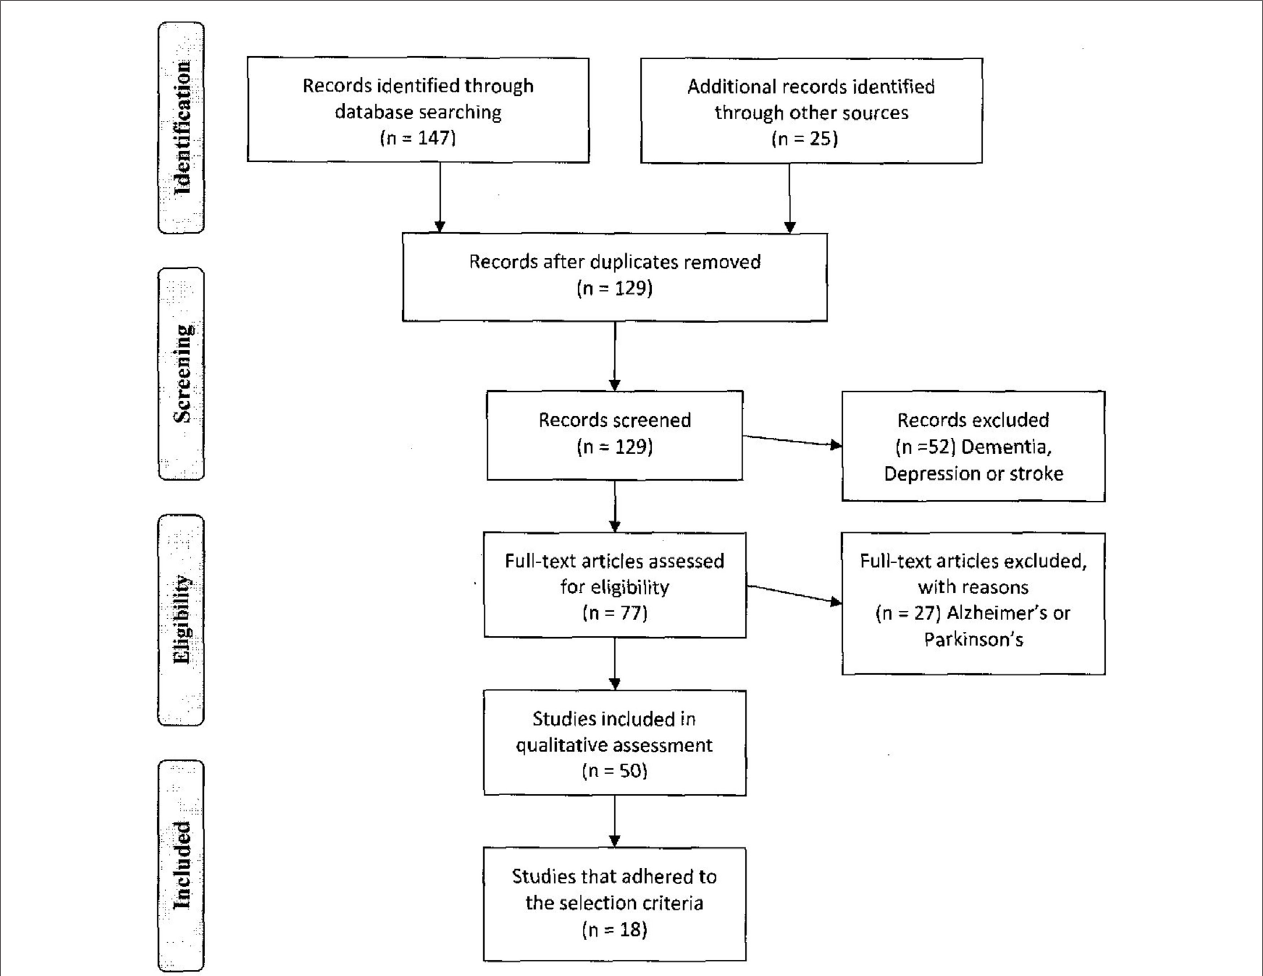
FiGURe 2 | PRiSMA diagram of the study selection process